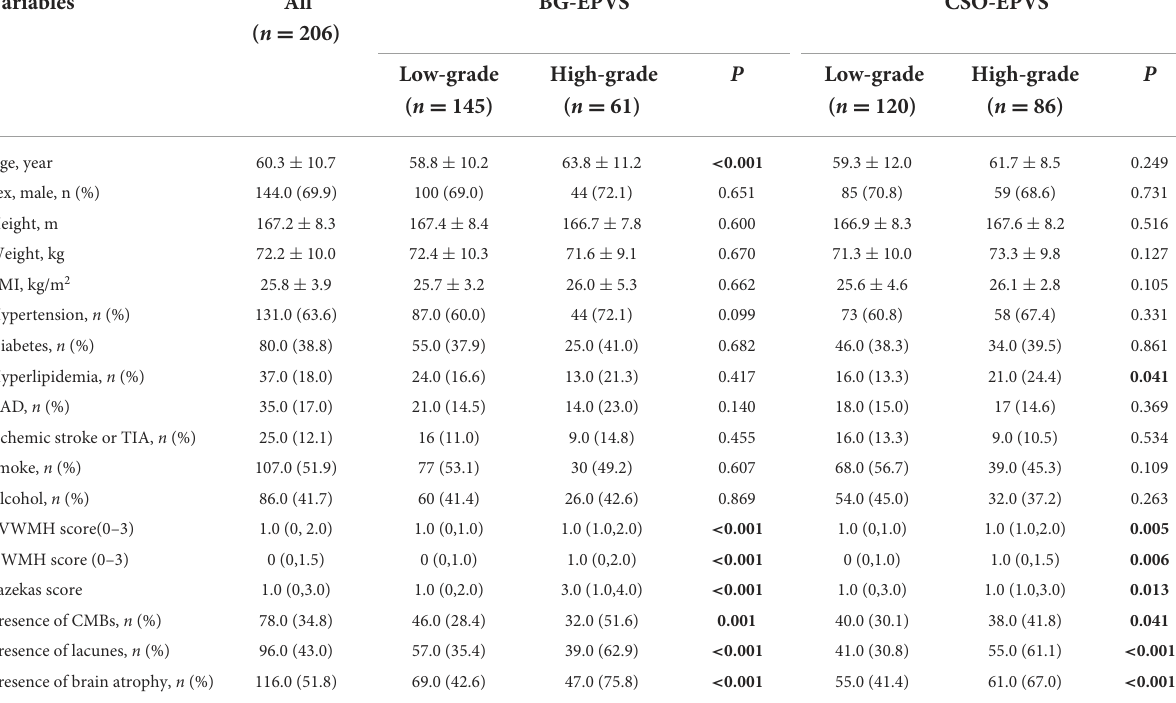
TABLE 1 Demographic, clinical, and CSVD characteristics of participants with different severities of EPVS. Variables